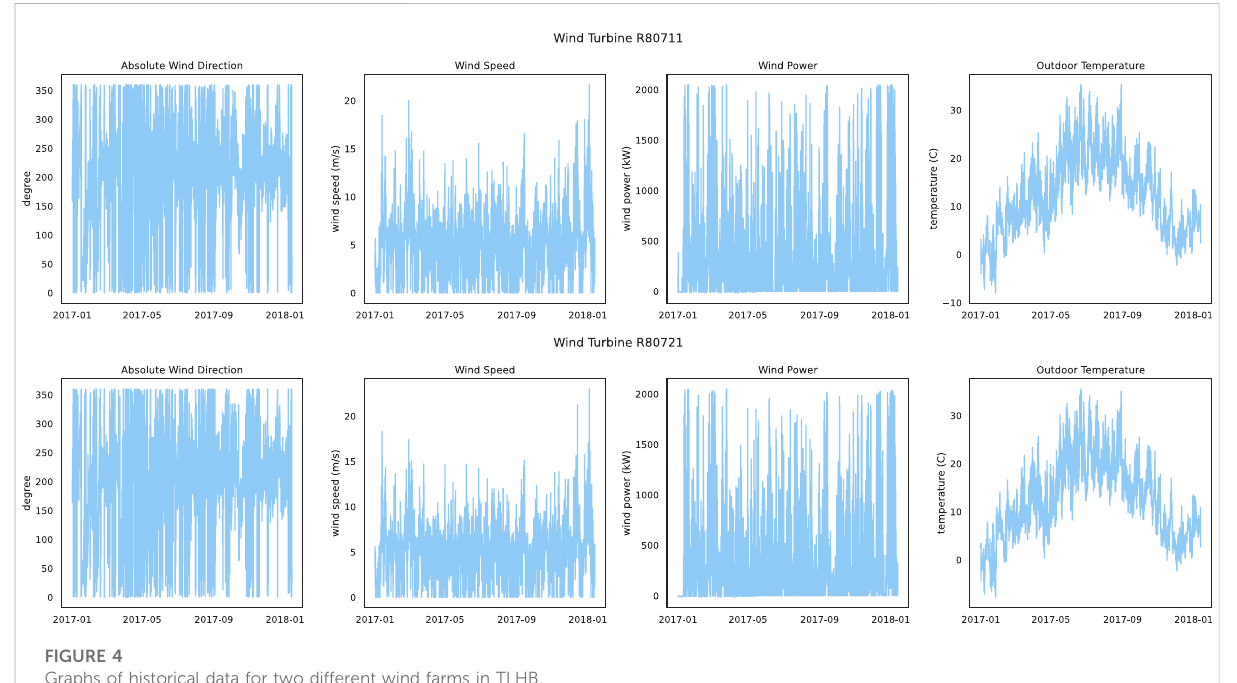
FIGURE 4 Graphs of historical data for two different wind farms in TLHB.